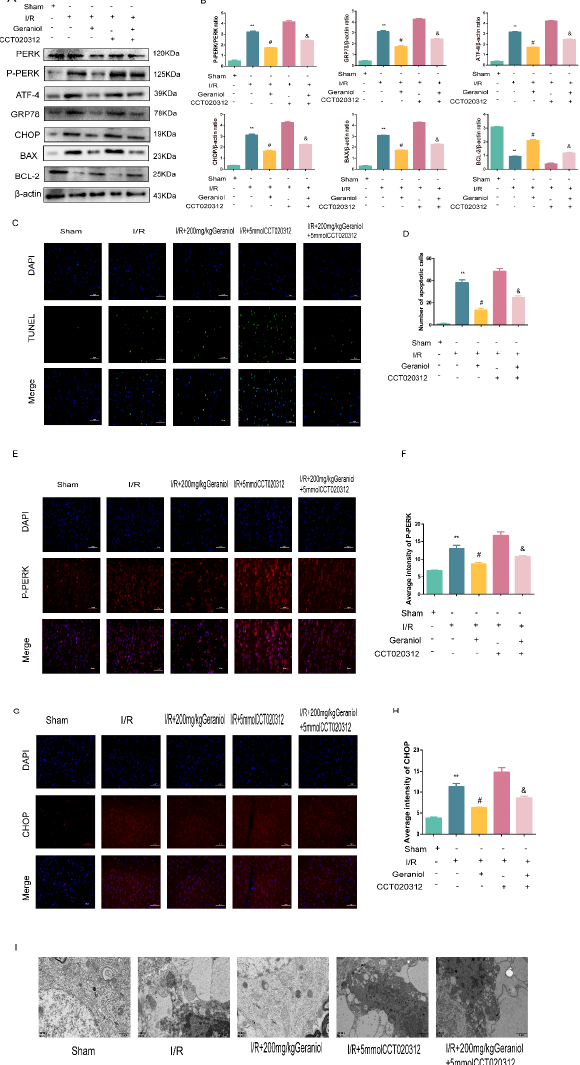
Figure 6. Geraniol-mediated protection against CIRI requires inhibition of endoplasmic reticulum stress via the PERK-ATF4-CHOP pathway. ( A , B ) Western blot analysis of PERK, P-PERK, ATF4, GRP78, BAX, BCL-2, and CHOP expression in the cortex ( n = 6). ( C – F ) Immunofluorescence staining of P-PERK and CHOP in the cortex. Representative images were acquired under 400 × magnification, scale bars = 50 µ m ( n = 3). ( G , H ) Apoptosis was detected in the cortex by TUNEL assays ( n = 3). Representative images were acquired under 400 × magnification, scale bars = 50 µ m. ( I ) Electron microscopy images of neuronal nuclei in the rat cerebral cortex (20,000 × ). ** p < 0.01 I/R group vs. sham group, # p < 0.01 I/R + 200 mg/kg geraniol group vs. I/R group, & p < 0.01 I/R + 200 mg/kg geraniol+5 mmol CCT020312 vs. I/R + 200 mg/kg geraniol